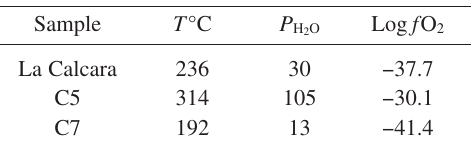
Table II. Estimated equilibrium temperature and pressures for the sampled gases. Water pressure and oxygen fugacity expressed in bars.